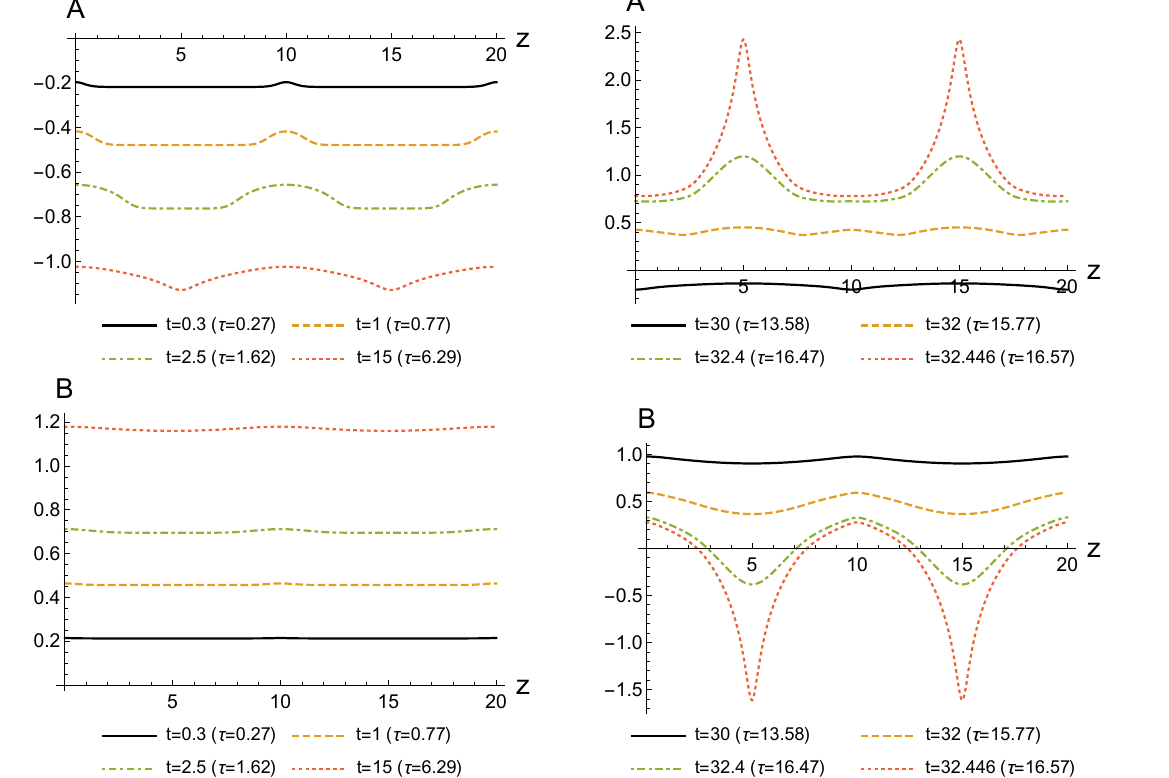
Figure 10 . The profiles of A and B at various times. The parameters are chosen as (4.6) and V min = − 0 . 05